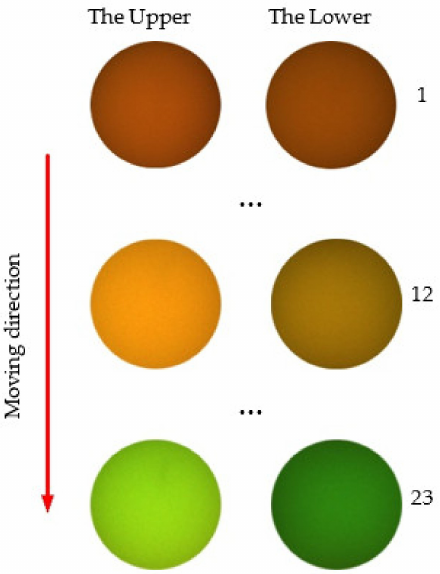
Figure 10. The color change of the calibration experiment. The H values of 23 focused spots were calculated through color conversion